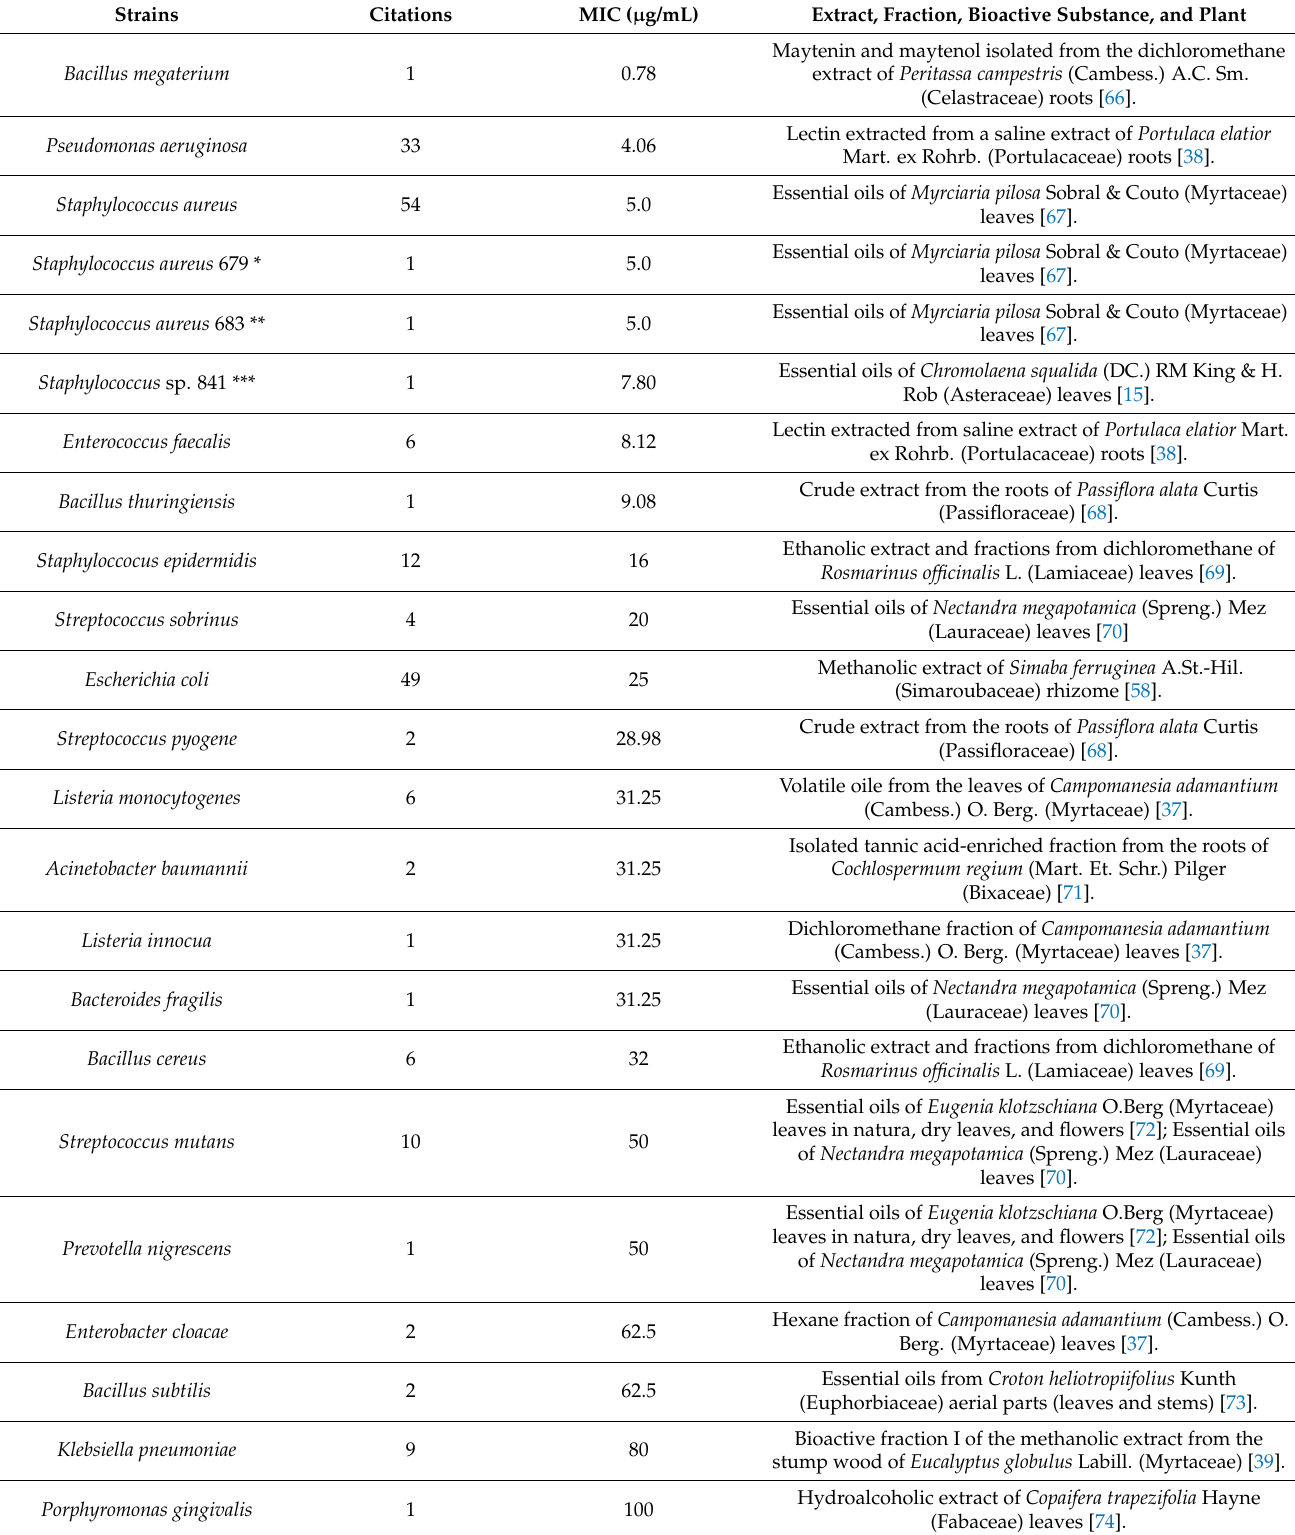
Table 3. Minimum inhibitory concentration (MIC) and number of citations for antibacterial